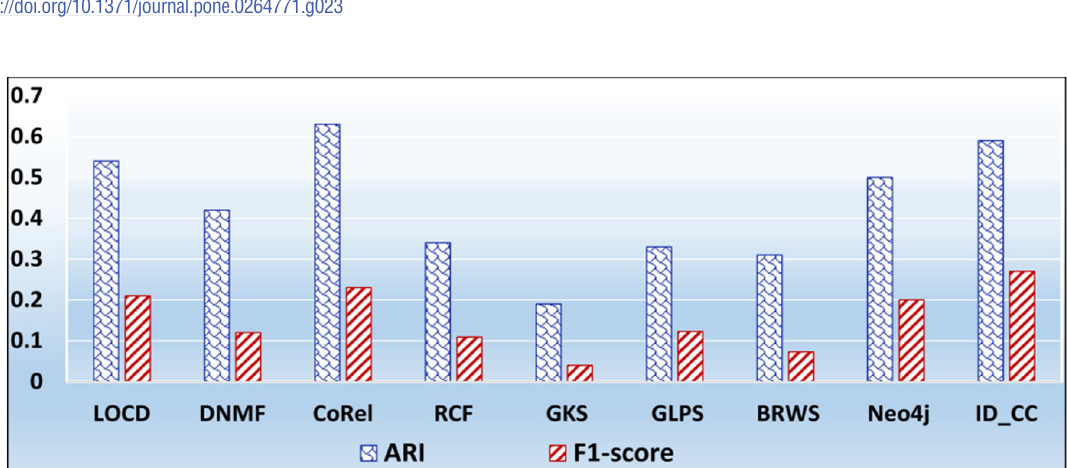
PLOS ONE | https://doi.org/10.1371/journal.pone.0264771 April 19,